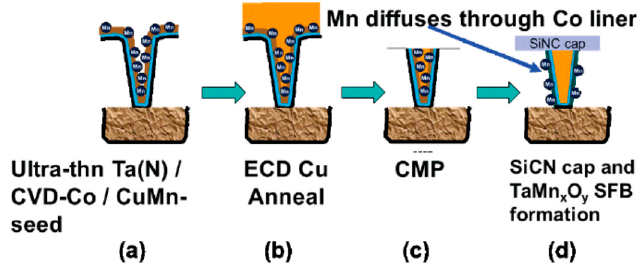
Figure 41. Through-Co self-forming barrier (tCoSFB) structure and process flow: ( a ) Ultra-thin Ta(N)/CVD-Co/ high-Mn% PVD-Cu(Mn) seed stack layer deposition; ( b ) Cu electroplating and anneal; ( c ) Cu CMP; ( d ) PECVD SiCN(H) dielectric cap and TaMnxOy SFB formation [277].